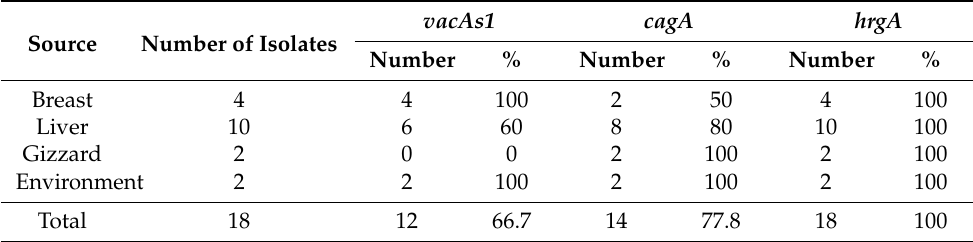
Table 4. Frequency distributions of the virulence genes in H. pylori isolates from chicken meat and environmental